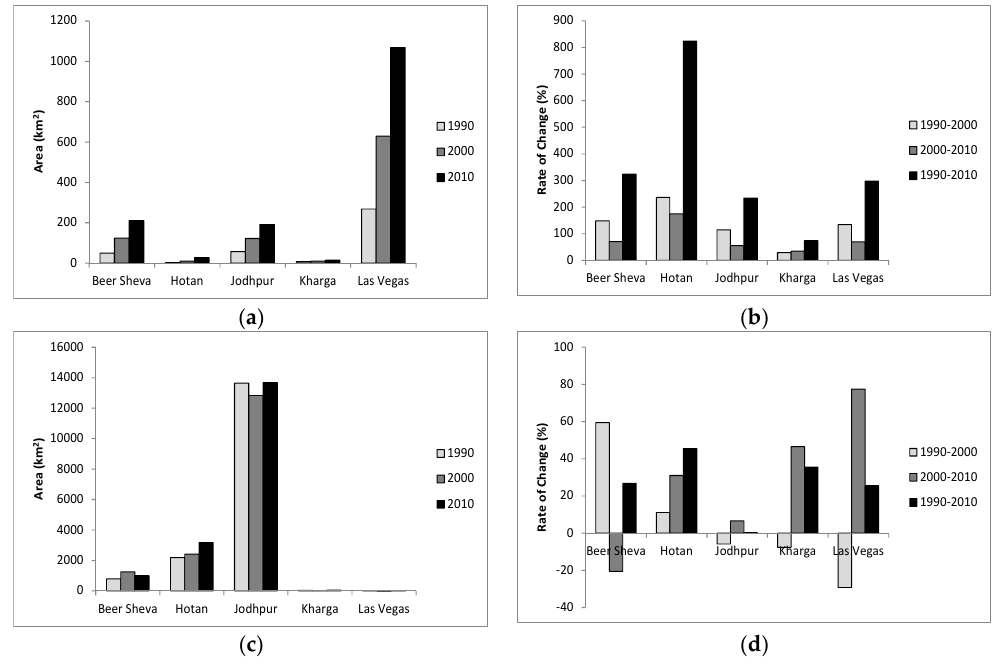
Figure 5. LCLU change pattern for urban and agriculture in the last two decades: ( a ) Change of urban area; ( b ) Rate of change for urban; ( c ) Change of agricultural land; ( d ) Rate of change for agriculture.